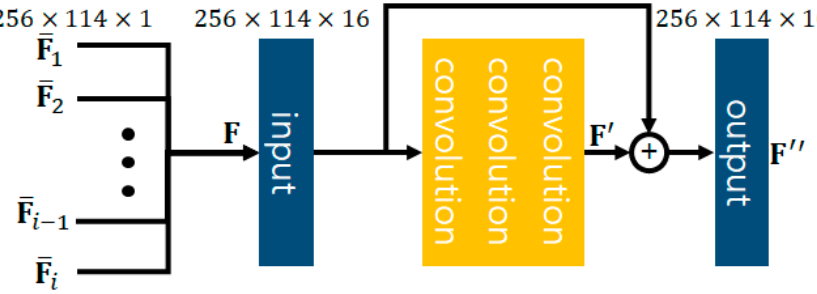
Figure 6. Configuration of a channel external convolution network.